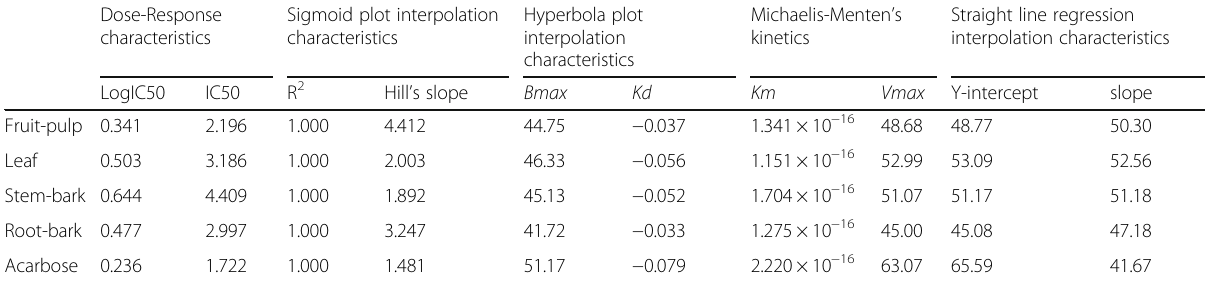
Table 4 Dose-response characteristics of the influence of Annona muricata ethyl acetate extracts on α -amylase activity Dose-Response